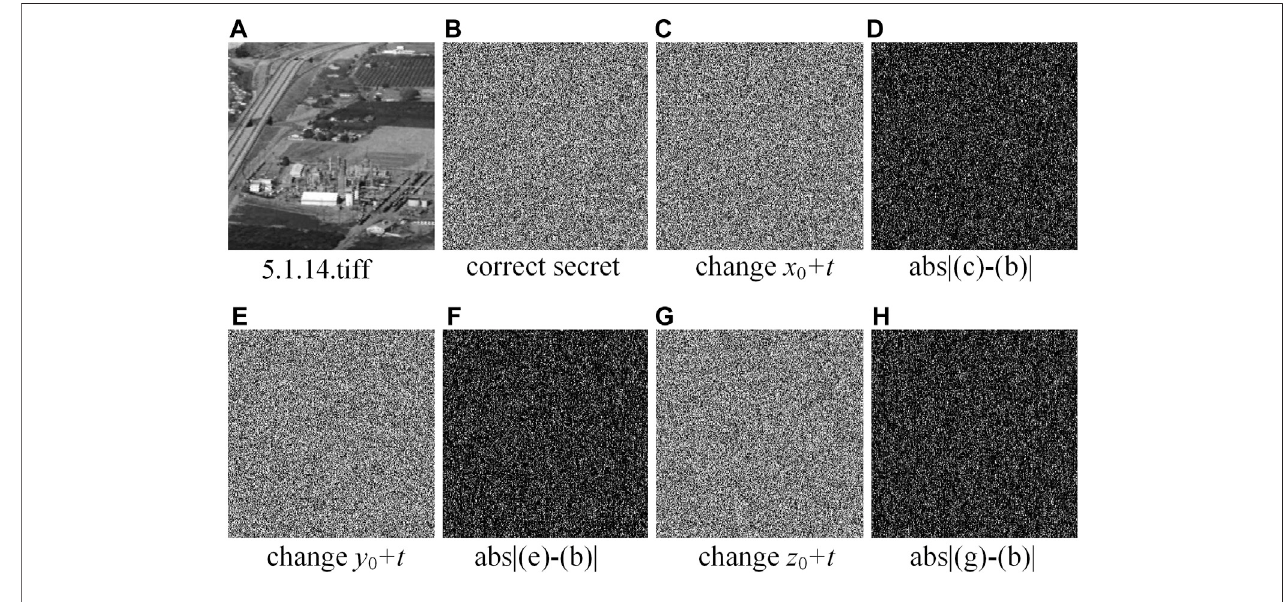
FIGURE 5 | Key sensitivity test in the ciphering stage [43].